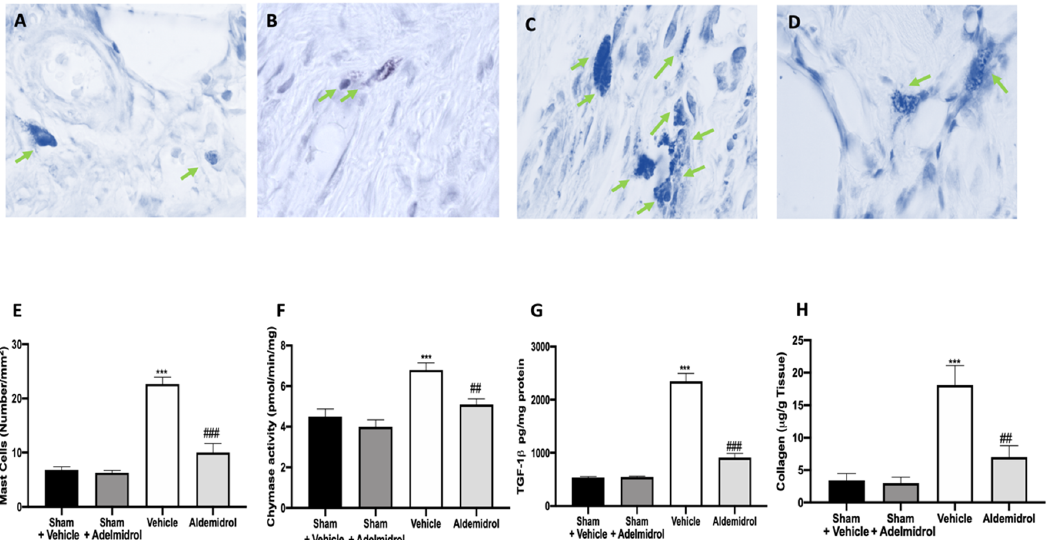
Figure 5. Effect of adelmidrol on mast cell analysis: Sham+vehicle ( A ), sham+adelmidrol ( B ), vehicle ( C ), adelmidrol ( D ); mast cell count ( E ); chymase activity ( F ); TGF-1 β ( G ) expression; collagen deposition ( H ) in lungs. ## p < 0.01 vs. vehicle, *** p < 0.001 vs. sham + vehicle, and ### p < 0.001 vs. vehicle.